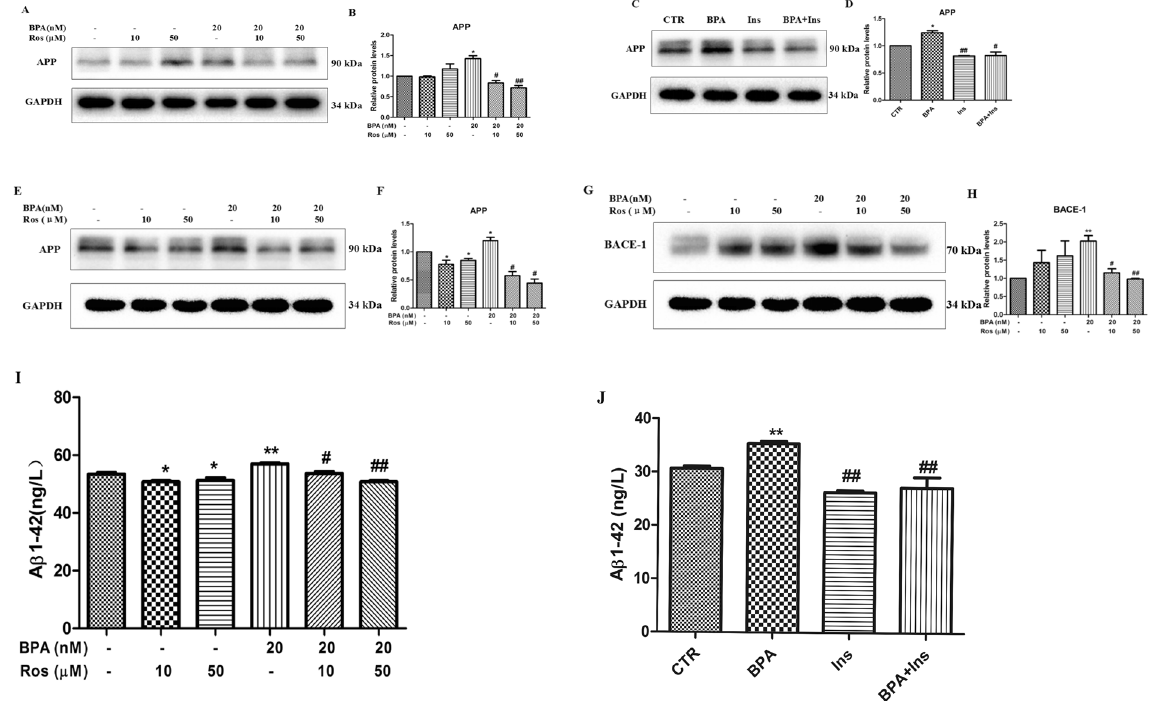
Figure 6. Effects of rosiglitazone on BPA-induced APP, BACE-1 and A β 1–42 expressions. ( A ) Effect of rosiglitazone on the expression of APP protein mediated by BPA in SY5Y cells. ( C ) Effect of rosiglitazone on the expression of APP protein mediated by BPA in PC-12 cells. ( E ) Effect of rosiglitazone on the expression of BACE-1 protein mediated by BPA in PC-12 cells. ( B , D , F , H ) GAPDH levels were assessed in parallel and served as controls. ( I ) ELISA analysis of the effects of rosiglitazone on A β 1–42 expression in PC-12 cells. ( J ) ELISA analysis of the effects of insulin on A β 1–42 expression in PC-12 cells. Mean values ± SEMs are representative of three independent isolations and three independent samples. Significant differences between the treatment groups and the control group were determined via one-way ANOVA and the Dunnett multiple comparison procedure. ( * P < 0.05, ** P < 0.01, *** P < 0.001 compared with the BPA single treatment group, # P < 0.05, ## P <